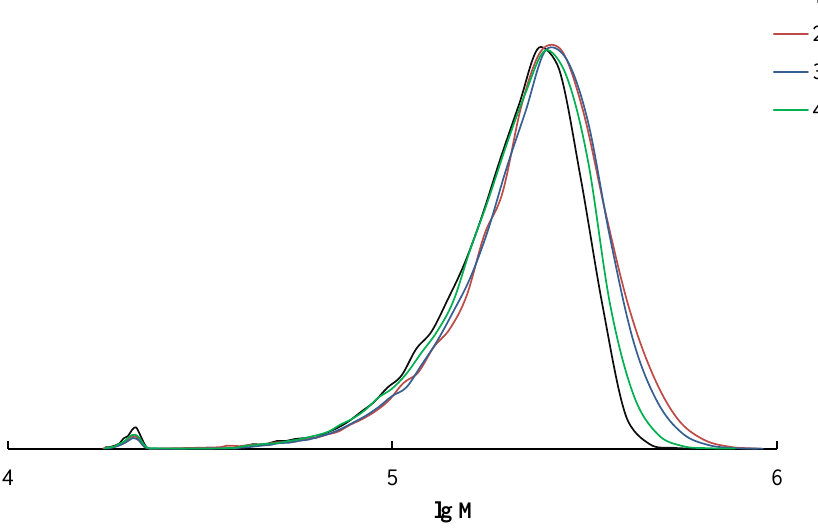
Figure 2. MWD of AA polymerization products in the presence of collagen and TBB synthesized for 3.5 h at 25 (2), 45 (3), or 60 °C (4), and of collagen (1). Table 2. Molecular weight parameters of collagen and PAA polymerization products in the presence of collagen and TBB at different synthesis temperatures (3.5 h synthesis